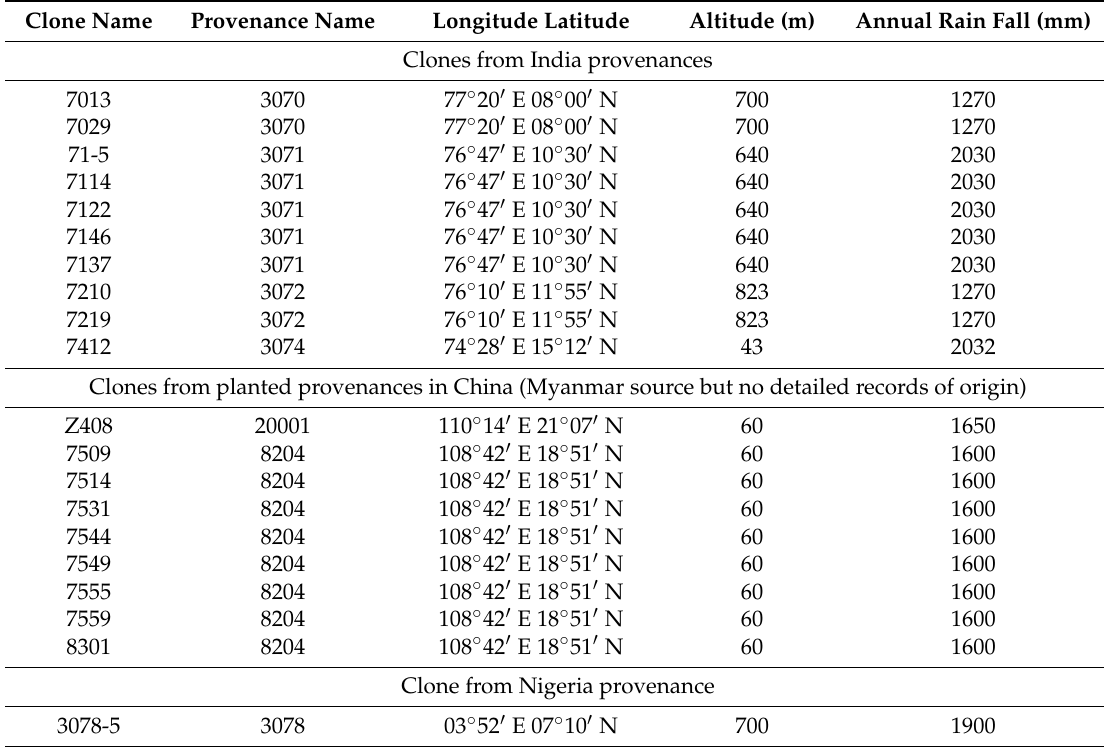
Table 1. Information of 20 commercial teak clones investigated in the